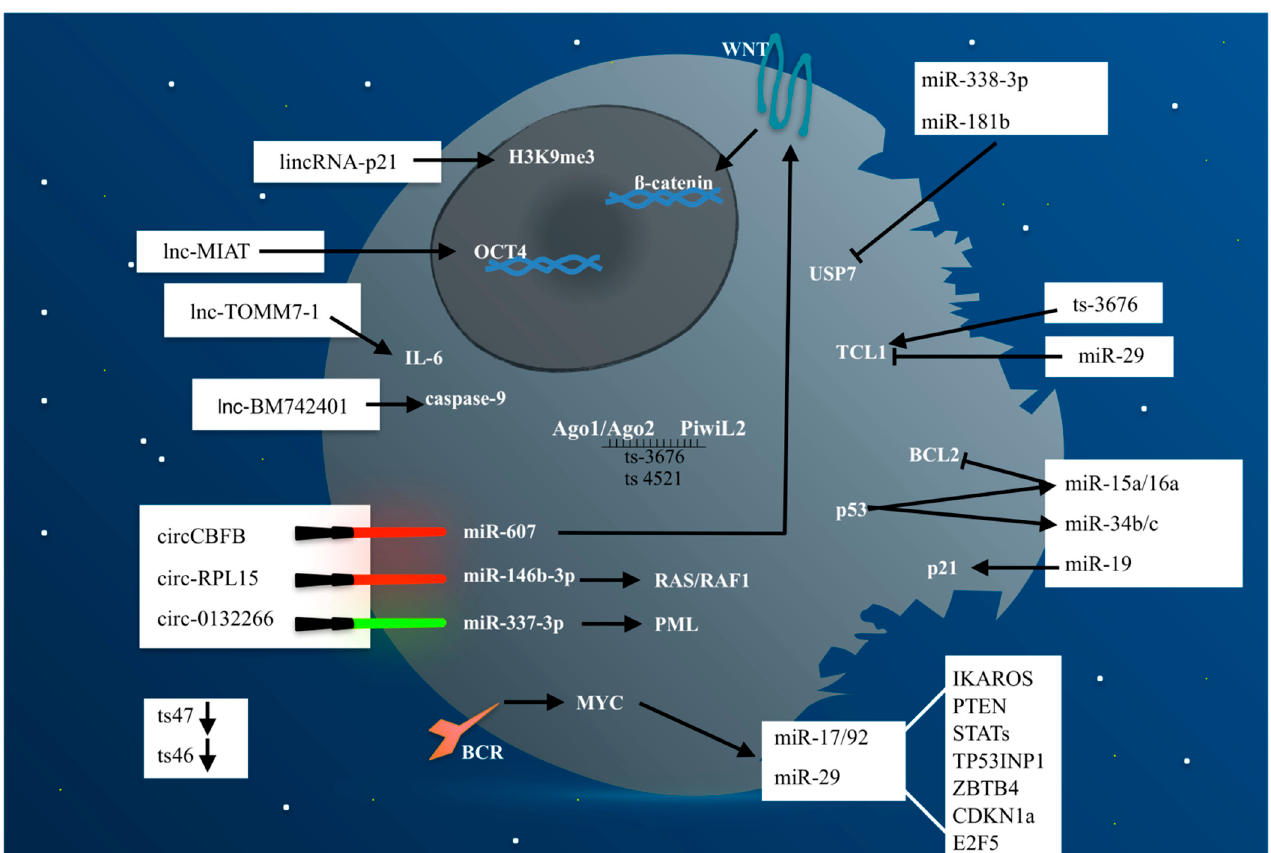
Figure 1. Non-coding RNAs represent the “dark side matter” in CLL pathogenesis. Indeed, although often underestimated they balance the levels of oncogene and onco-suppressor proteins responsible of CLL development and progression. In Figure 1, the CLL cell is symbolized as a “black death” in which ncRNAs (miRNAs, lncRNAs, circRNAs, and tsRNAs) represent the “dark side matter” as opposed to the coding part (“non-dark matter”), both involved in the deregulated pathways responsible for CLL development and progression. The red swords represent a silencing mechanism, whereas green swords represent an inducing mechanism. Arrows indicate activation, whereas bar-headed lines indicate inhibition.